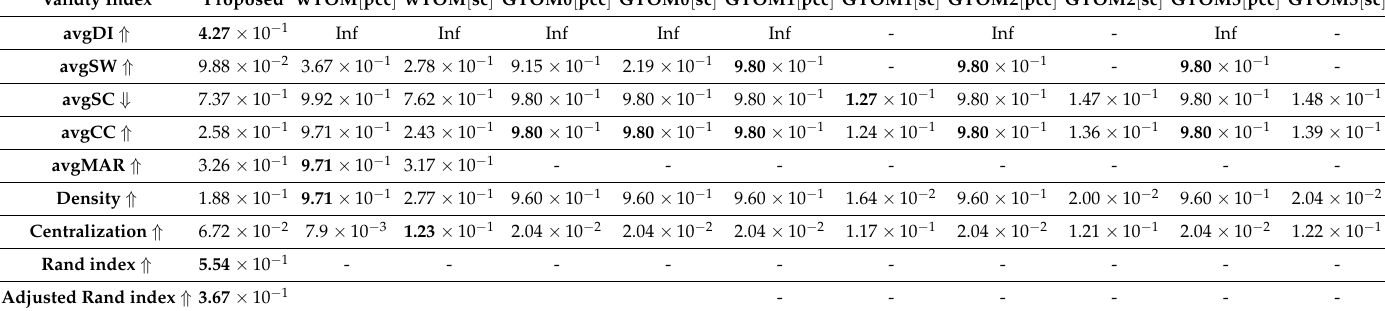
Table 8. Comparison of the proposed rule-based gene-module detection method and other existing geneset-based gene-module detection methods in the second simulation study for the cervical carcinogenesis